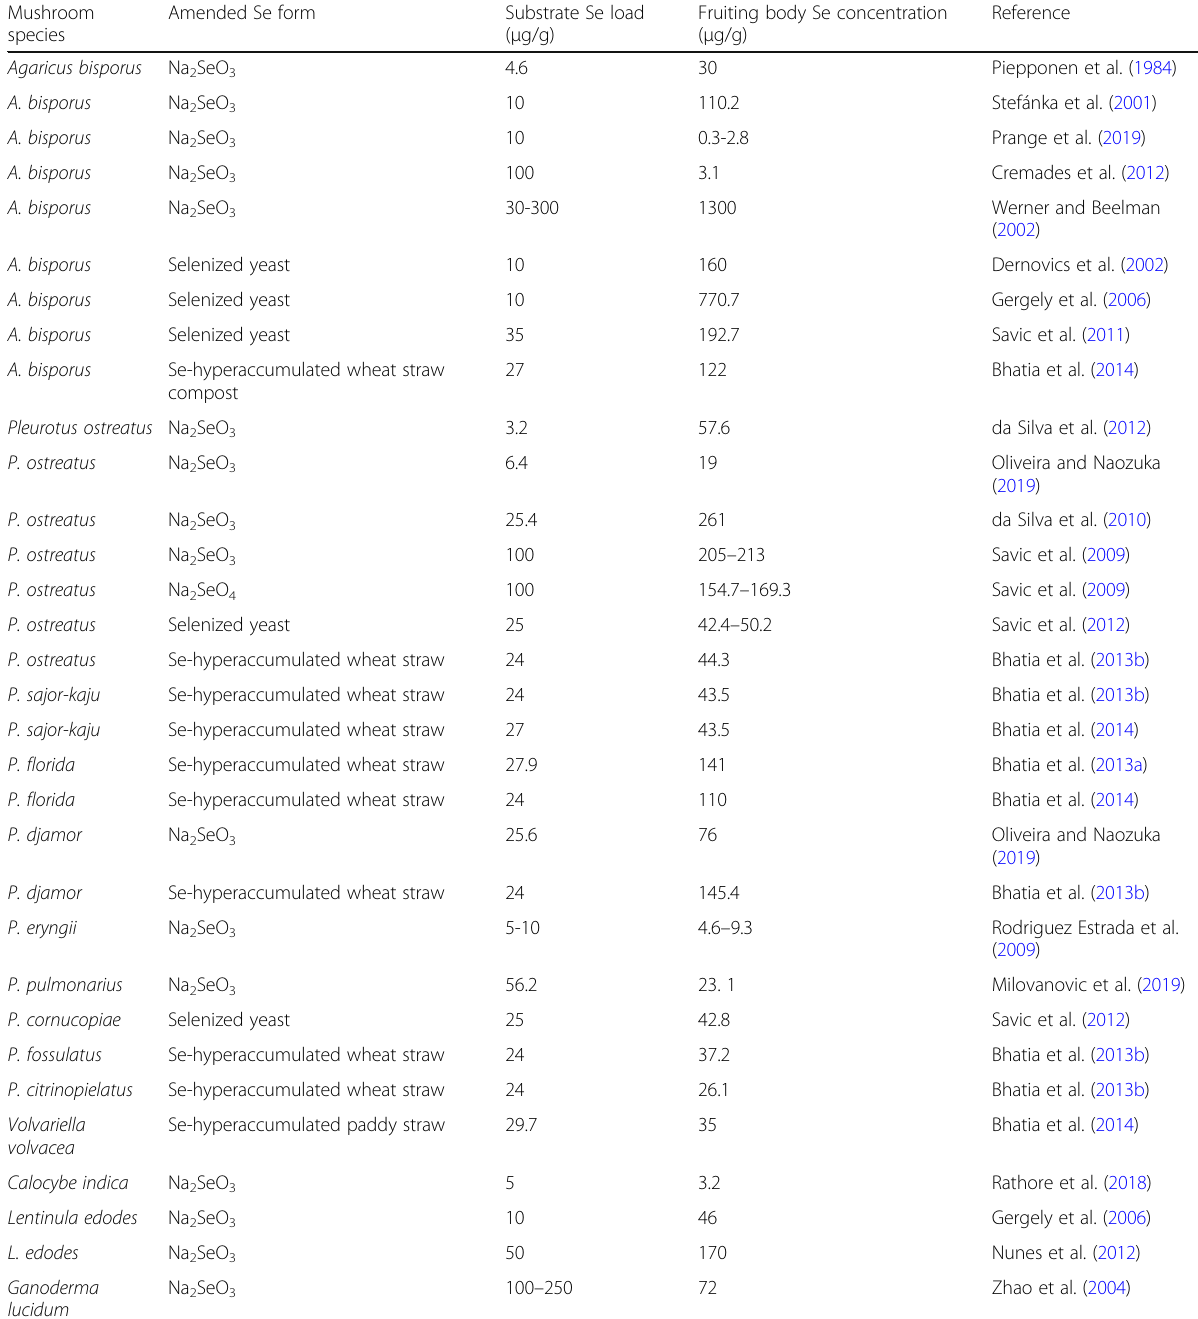
Table 1 A comparative account of selenization methods reported for various species of edible mushrooms, in terms of amended Se form, Se load in substrate and bioaccumulated Se concentration in fruiting bodies Mushroom